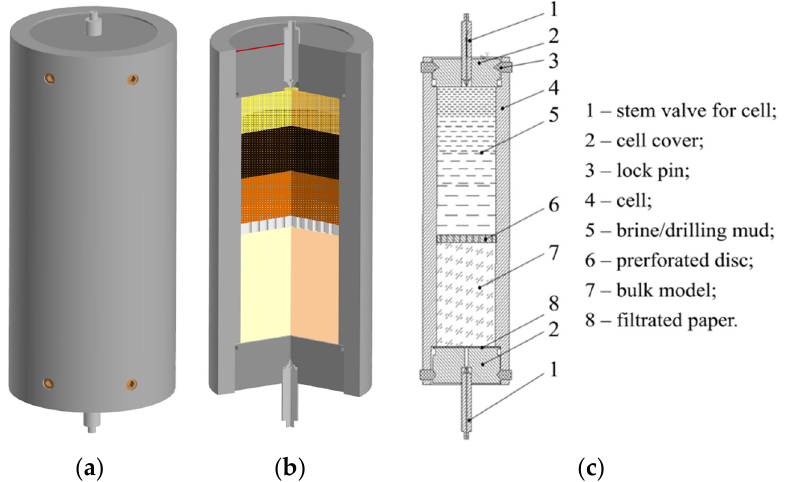
Figure 1. Scheme of the chamber of the modified cell (500 mL) of the OFFITE HTHP filter press for determining the curing ability of blocking compounds. ( a ) 3D layout of the cell; ( b ) 3D layout of the cell in section; and ( c ) cell drawing with positions.